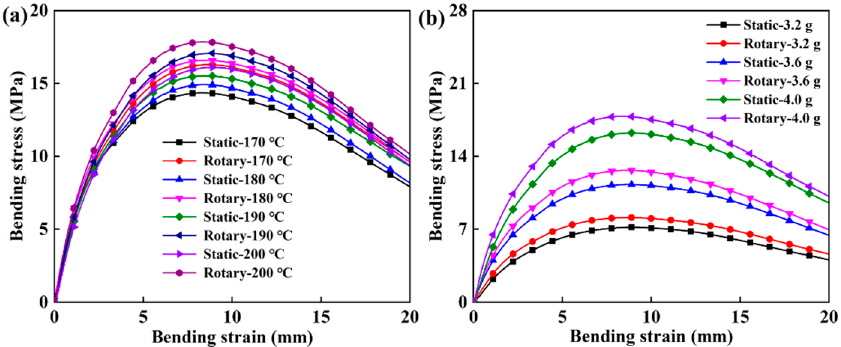
Figure 7. The bending strength of the product under different process conditions: ( a ) Trends of bending behavior of samples obtained by different molding methods with respect to the change in temperature when the charging amount was 4 g, and ( b ) trends of bending behavior of samples obtained by different molding methods with respect to the change in charging amount when the sintering temperature was 200 °C.